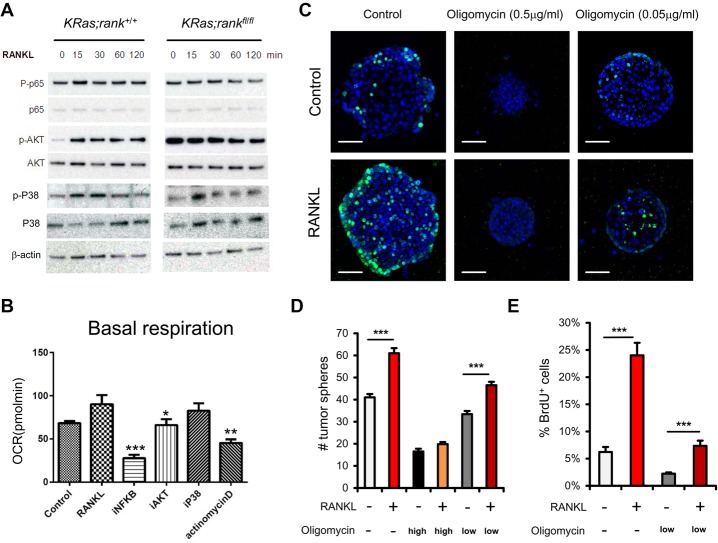
Mitochondrial respiration controls proliferation of lung cancer stem-like cells. (A) Western blotting of primary KRas;rank+/+ and KRas;rankfl/fl pneumocytes to determine activation of the indicated signaling pathway in response to 1 µg/mL RANKL stimulation. Activation was determined at the indicated time points using phospho-specific antibodies. The respective total proteins are shown to control for protein expression. β-Actin is shown as a loading control. (B) Bioenergetics profiling of purified primary pneumocytes from KRas;rank+/+ mice. Mutant KRas was induced following AdCre infections, and cells were then left untreated (control) or treated with 1 µg/mL RANKL in the presence or absence of inhibitors to block NF-κB (iNF-κB), AKT (iAKT), P38 (iP38), and transcription (actinomycin D). In all experiments, cells were pretreated with the inhibitors. A minimum of five replicates was analyzed for each condition, and pneumocytes purified from two different mice were used independently. (*) P < 0.05; (**) P < 0.01; (***) P < 0.001, unpaired two-sided t-test. (C) Representative images for BrdU staining of tumor spheroids derived from KRas;rank+/+ primary lung tumor cells, which received no treatment or were treated with 1 µg/mL RANKL alone, oligomycin alone (low dose [0.05 µg/mL] or high dose [0.5 µg/mL]), and RANKL plus different oligomycin concentrations. Five-thousand primary tumor cells were seeded. BrdU labeling (10 µM/mL) was performed for 2 h. Experiments were performed with six replicates for each condition and repeated with three different KRas;rank+/+ mice. Sections were counterstained with DAPI. (D,E) Quantifications (mean ± SEM) of tumor spheroid numbers and BrdU+ cells within tumor spheroids from C. (***) P < 0.001, unpaired two-sided t-test. Bars, 50 µm.